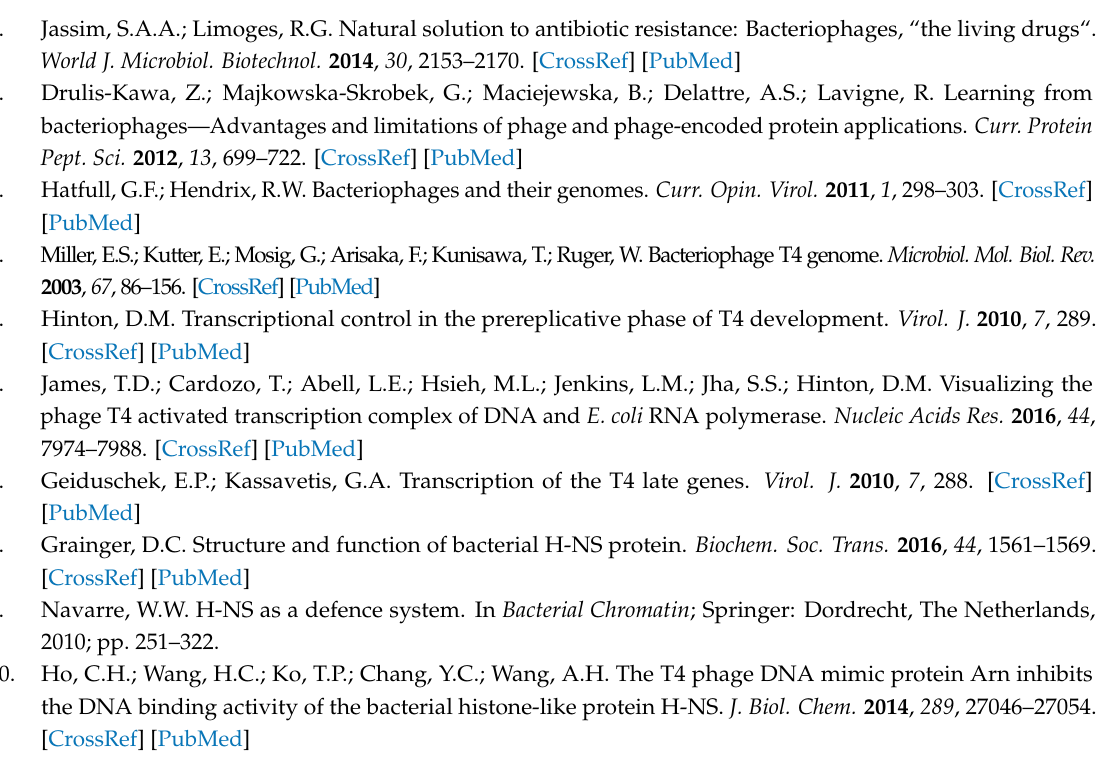
Figure S1: GC-contents of total RNA have a bimodal distribution for T4 wt infections; Figure S2: Toxicity of C-terminally tagged MotB constructs in E. coli ; Figure S3: Purification of MotB; Figure S4: MotB binding to P8 oligonucleotides of various lengths; Figure S5: Effect of heterologous production of MotB on T4 plaque size; Figure S6: Primer extension products from selected T4 promoters in a T4 wt or a T4 motB am infection at 1 min and 5 min post-infection; Figure S7: Transcripts in early, middle, and late regions are similar in T4 wt (+) or T4 motB am ( am ) infections of NapIV NS; and Table S1: Summary of all RNA-seq and RT-qPCR